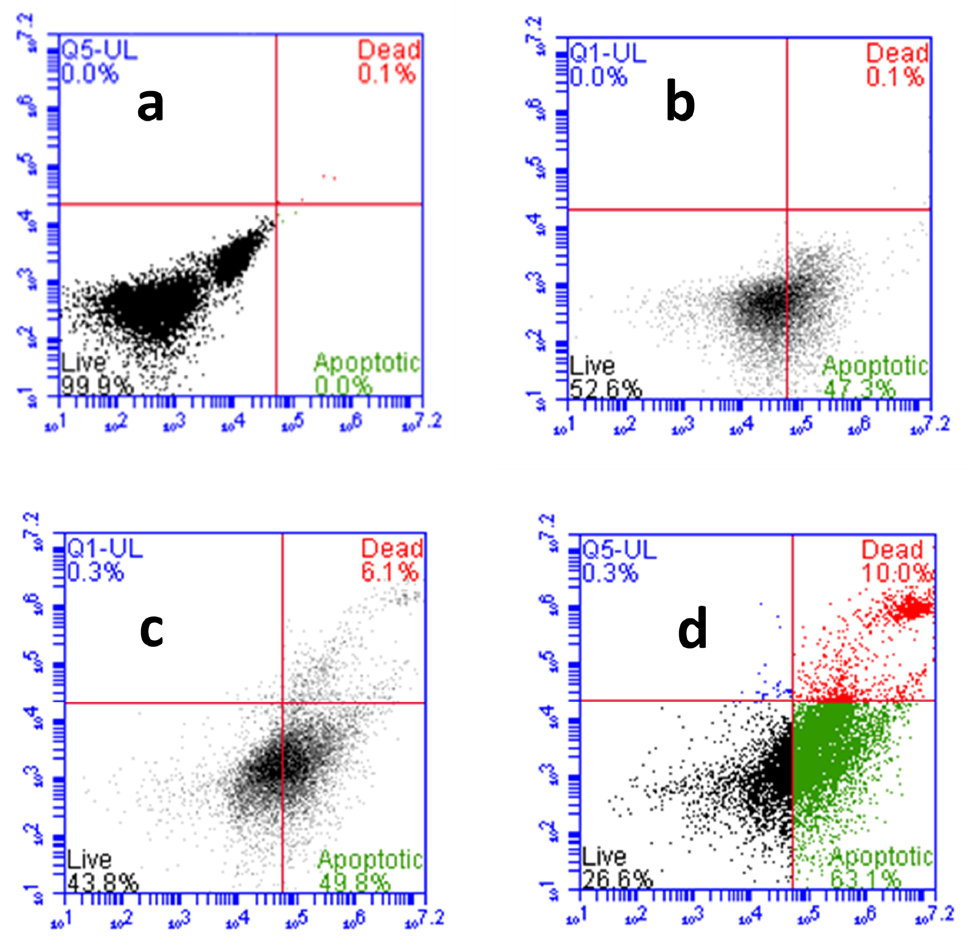
Figure 8. Effects of CA and PDT on cell death of A549 cells by Annexin V-FITC/PI staining. Where, Figure 8. E ff ects of CA and PDT on cell death of A549 cells by Annexin V-FITC / PI